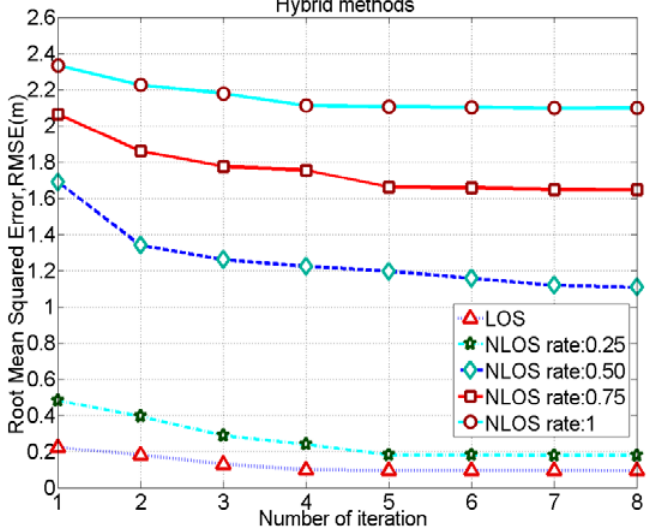
Figure 10. Performance of the hybrid method in each iteration for different NLOS conditions, considering fingerprinting polygon size: 20 cm and signal sampling rate: 50 GHz.